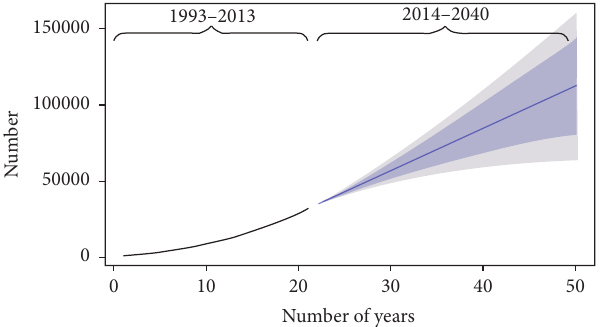
Figure 2: Trend and forecast values for prevalence of ESRD patients (ARIMA [ 0 , 2 , 1